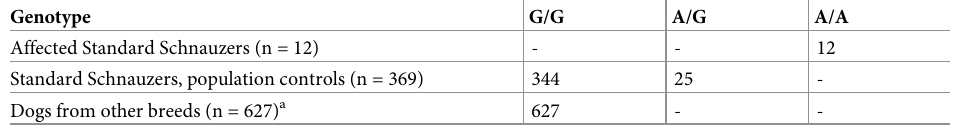
a These dogs do not include the 221 control genomes, which were used for the initial analysis. Thus, in total, the mutant allele was absent from > 800 dogs of other breeds.